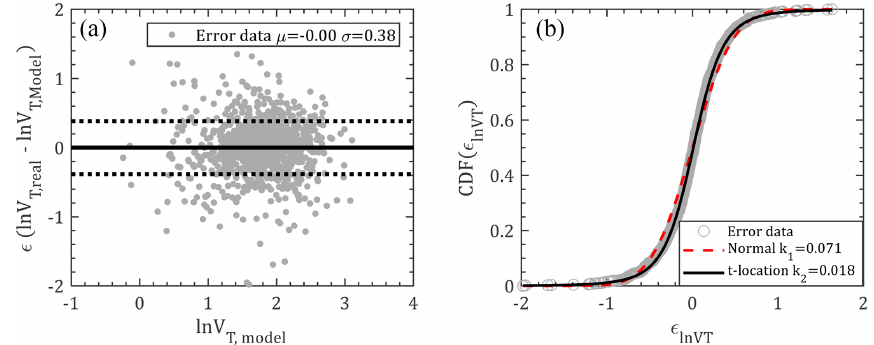
Figure 5. Logarithmic modeling errors for translation speed: (a) scatterplot; (b) CDF.